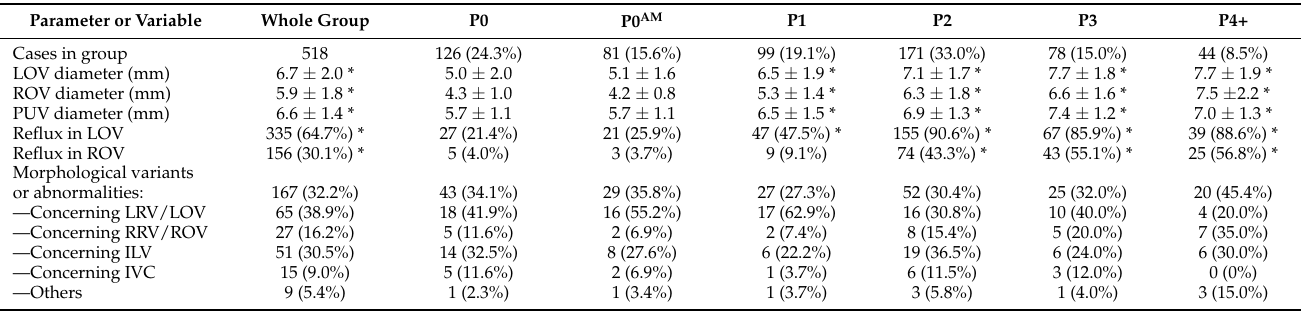
Table 2. Association of selected morphological parameters of abdominal/pelvic veins with the number of pregnancies (P). Parameter or Variable